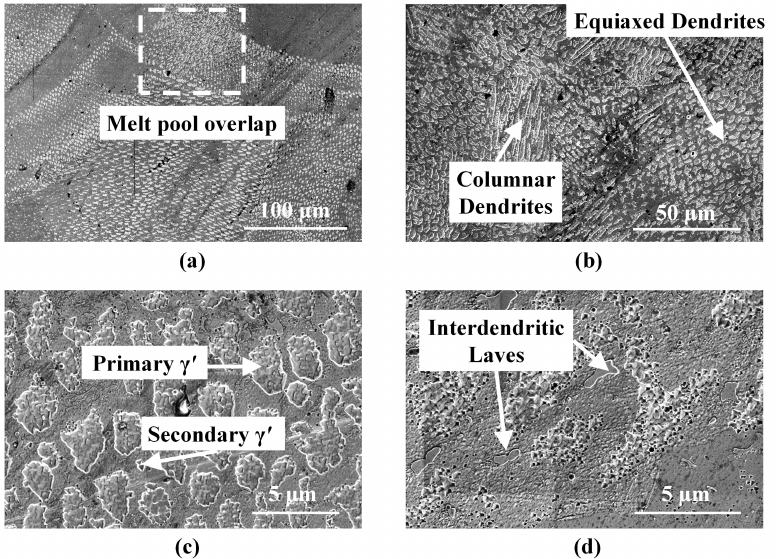
Figure 9. SEM images of the powder-fed L-DED specimen: ( a ) at the bottom of the deposit showing overlapping melt pool boundary; ( b ) at the middle of the deposit where both equiaxed and columnar dendrites are observed; and ( c ) at the top of the build where larger γ (cid:48) precipitates are observed due to a decrease in the cooling rate. ( d ) A representative SEM image of the deposit where Laves phases are observed in the interdentritic regions.